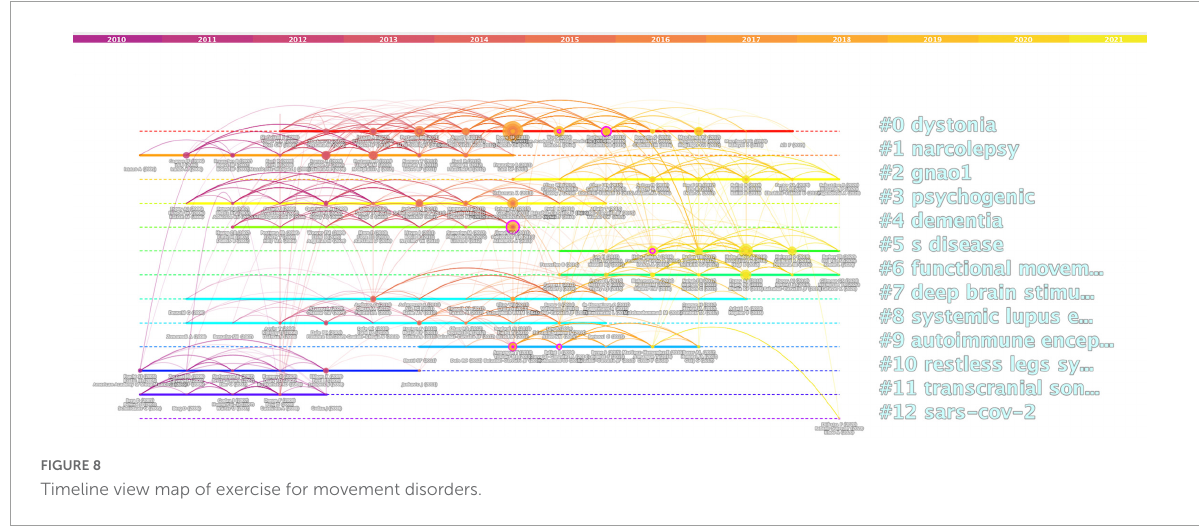
FIGURE8 Timeline view map of exercise for movement disorders.